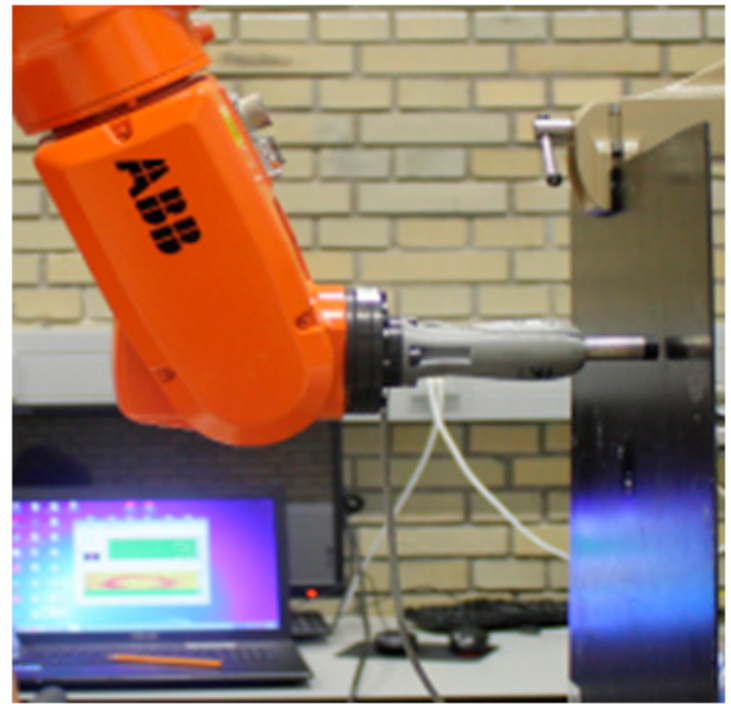
Figure 14. Experimental setup for robotic scanning.